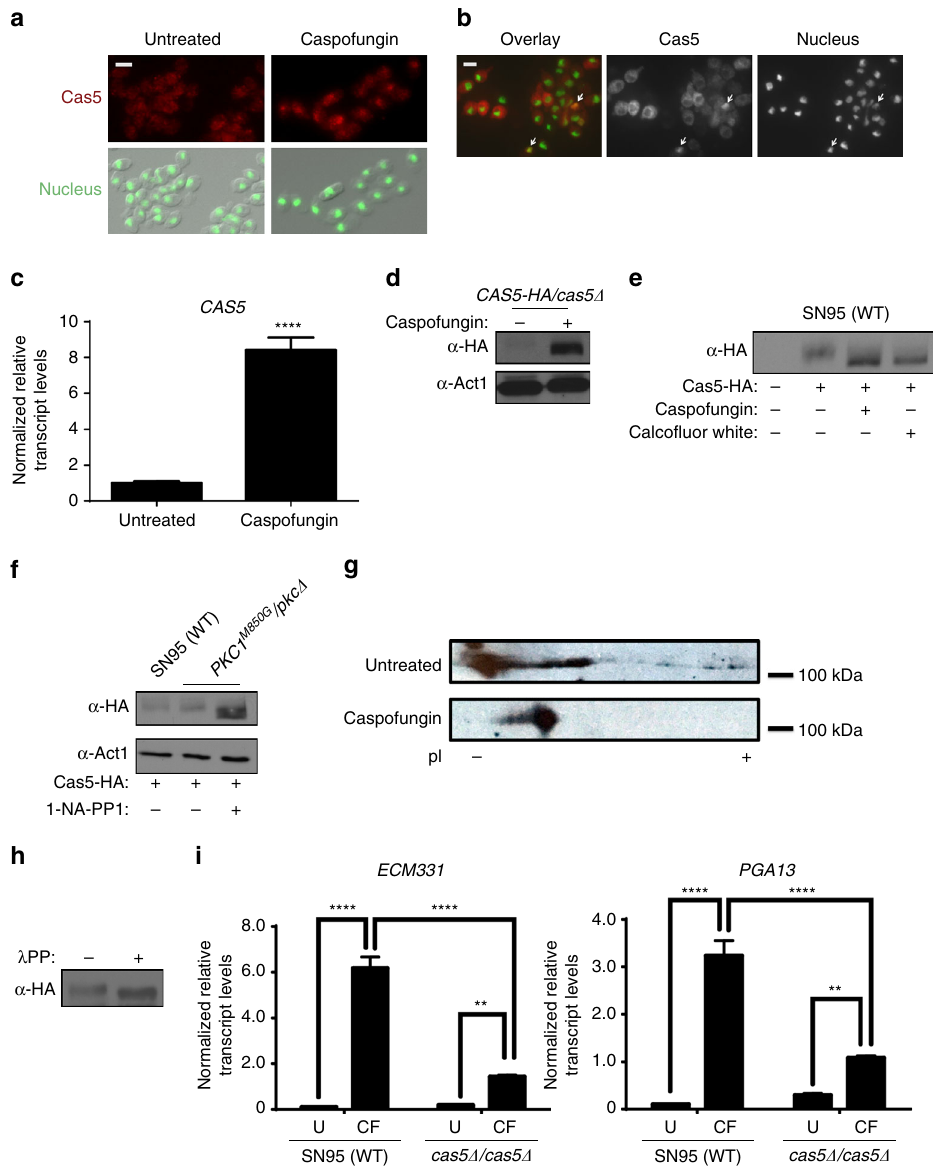
Fig. 5 Cas5 becomes activated by dephosphorylation in response to cell wall stress. a Cas5 localizes to the nucleus in response to caspofungin. Cells were fi xed and Cas5 ( red ) was detected by indirect immuno fl uorescence using α -HA antibody and α -mouse IgG-Cy3. Nuclei ( green ) were visualized by DAPI staining. Scale bar represents 5 μ m. b Cells were subcultured in rich medium to log phase and fi xed. HA-tagged Cas5 ( red ) and nuclei ( green ) were visualized as in a . Scale bar represents 5 μ m. c CAS5 is induced by caspofungin. The transcript level of CAS5 was monitored by qRT-PCR and normalized to GPD1 . Error bars represent standard deviation (s.d.) from the mean of triplicate samples. Signi fi cance was measured with an unpaired t test in GraphPad Prism (**** P < 0.0001). d Levels of Cas5 were monitored by western blot and detected with an α -HA antibody. Actin was detected with an α - β -actin antibody as a loading control. Full blots are shown in Supplementary Fig. 2b. e Cas5 is post-translationally modi fi ed upon cell wall stress treatment. Cells were grown to log phase and subsequently treated with 125 ng/ml of caspofungin or 50 μ g/ml of calco fl uor white for 1 h. Total protein was resolved by SDS-PAGE and the blot was hybridized with an α -HA to monitor Cas5 migration. Full blots are shown in Supplementary Fig. 2c. f Cas5 migration and actin detection were monitored as part d . Full blots are shown in Supplementary Fig. 2d. g Protein lysates were subjected to two-dimensional gel electrophoresis coupled with western blotting. Cas5 was detected with an α -HA antibody. h Cas5 is phosphorylated in the absence of stress. Cas5 migration was monitored by western blot and detected with an α -HA antibody. Treatment of protein lysate with lambda phosphatase resulted in a faster migrating band. Full blots are shown in Supplementary Fig. 2e. i Cas5 is required for caspofungin ( CF )-induction of cell wall genes. Transcript levels of ECM331 and PGA13 were monitored by qRT-PCR and normalized to GPD1 . Error bars represent s.d. from the mean of triplicate samples. Signi fi cance was measured with